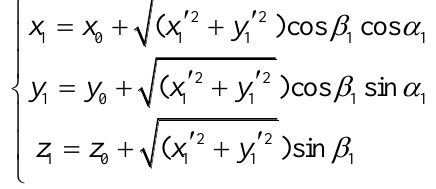
Figure 7. The coordinate translation